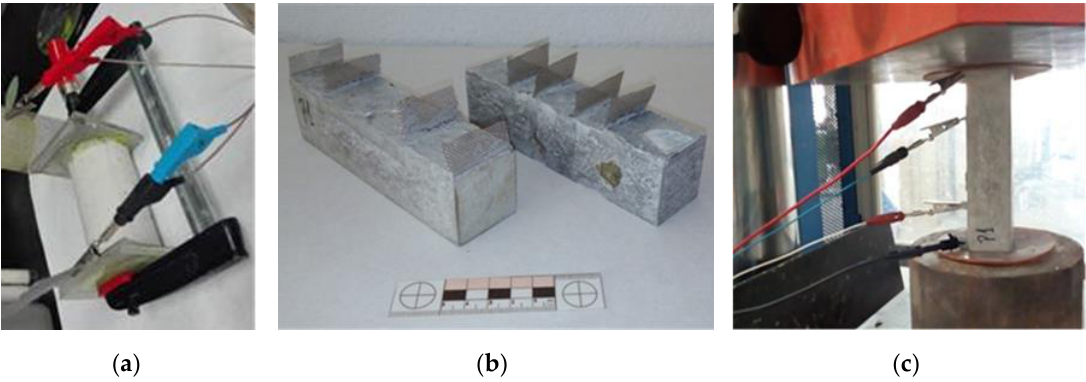
Figure 2. ( a ) electrical resistance, direct method; ( b )the sample geometry and sensor location; and ( c ) the piezoresistivity (PZR) arrangement.